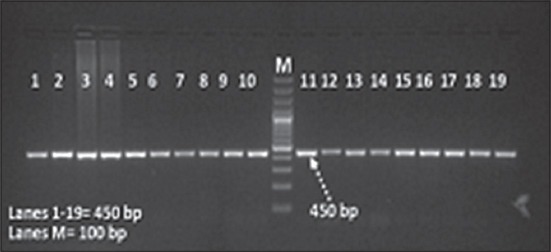
PCR amplification of exon 3 of HSP90AA1 gene in Sahiwal cow (M=100bp)